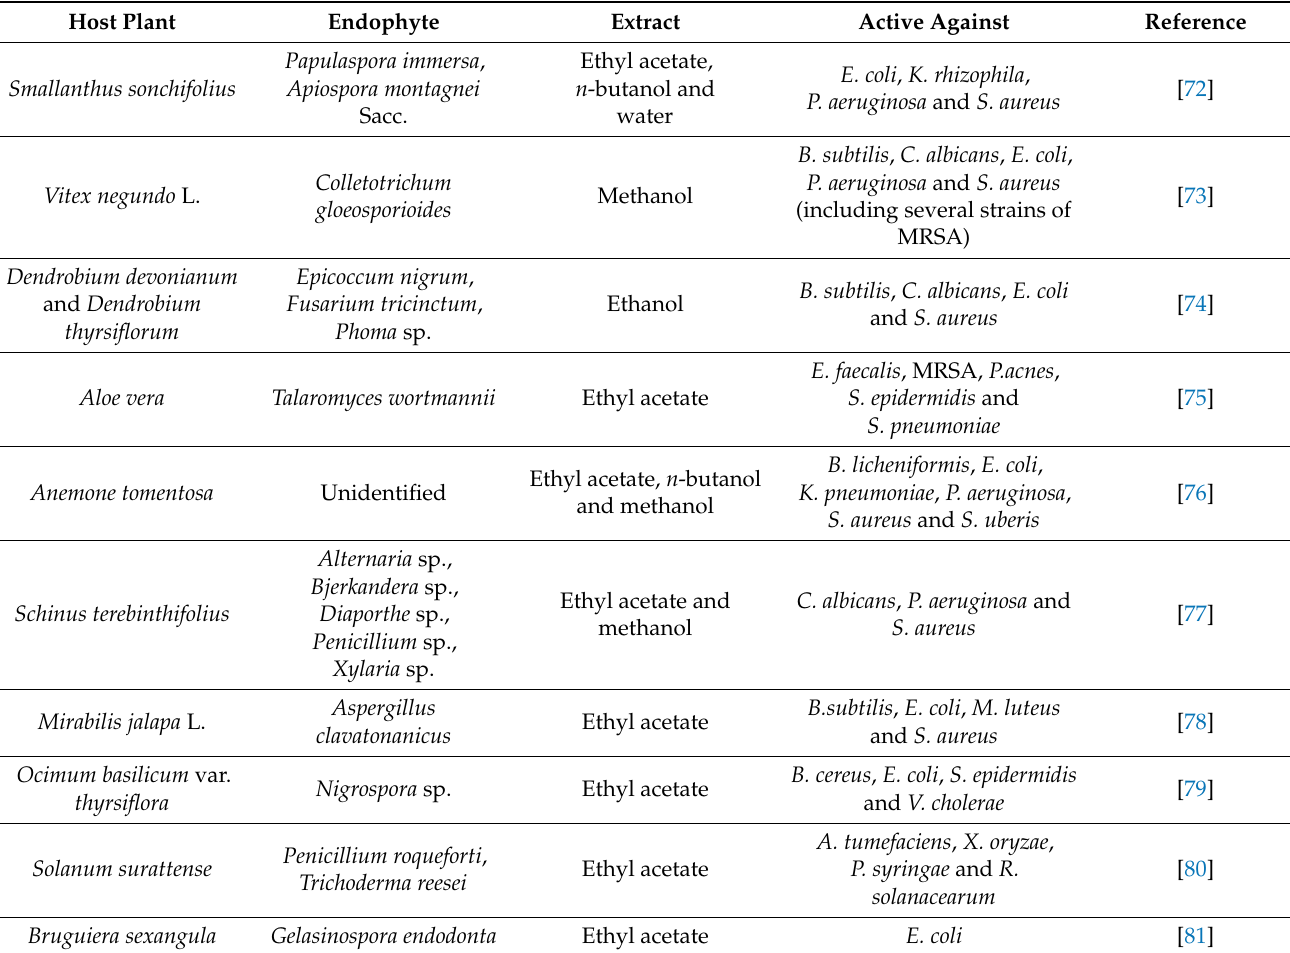
Table 1. List of crude extracts obtained from endophytes that exhibit antimicrobial